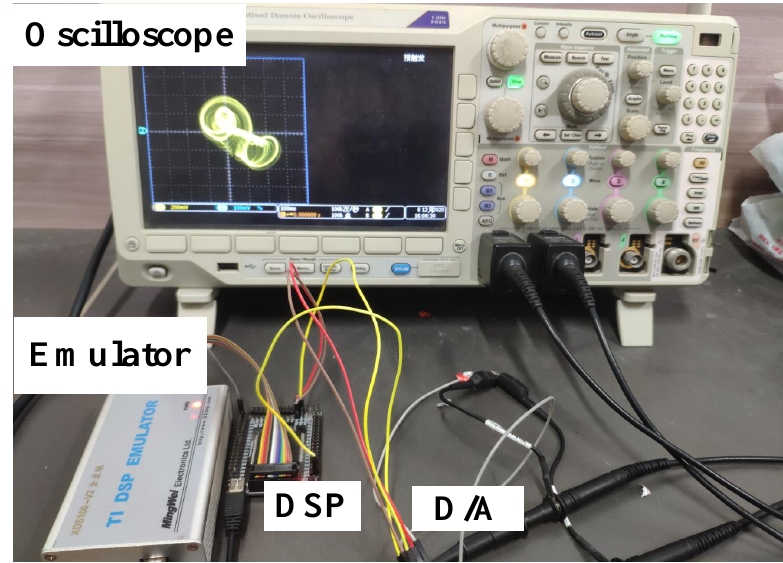
Figure 13. The DSP implementation hardware connection